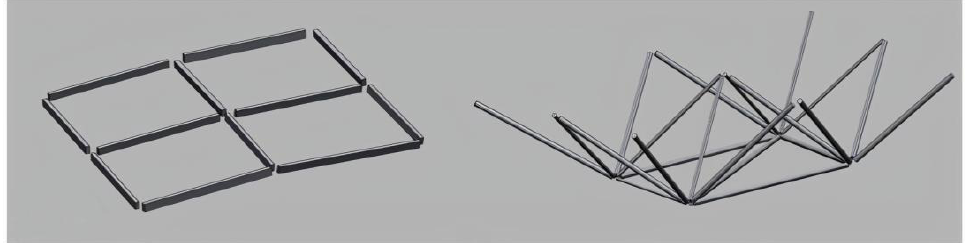
Figure 36. Solid geometries built starting from the approximate mesh.